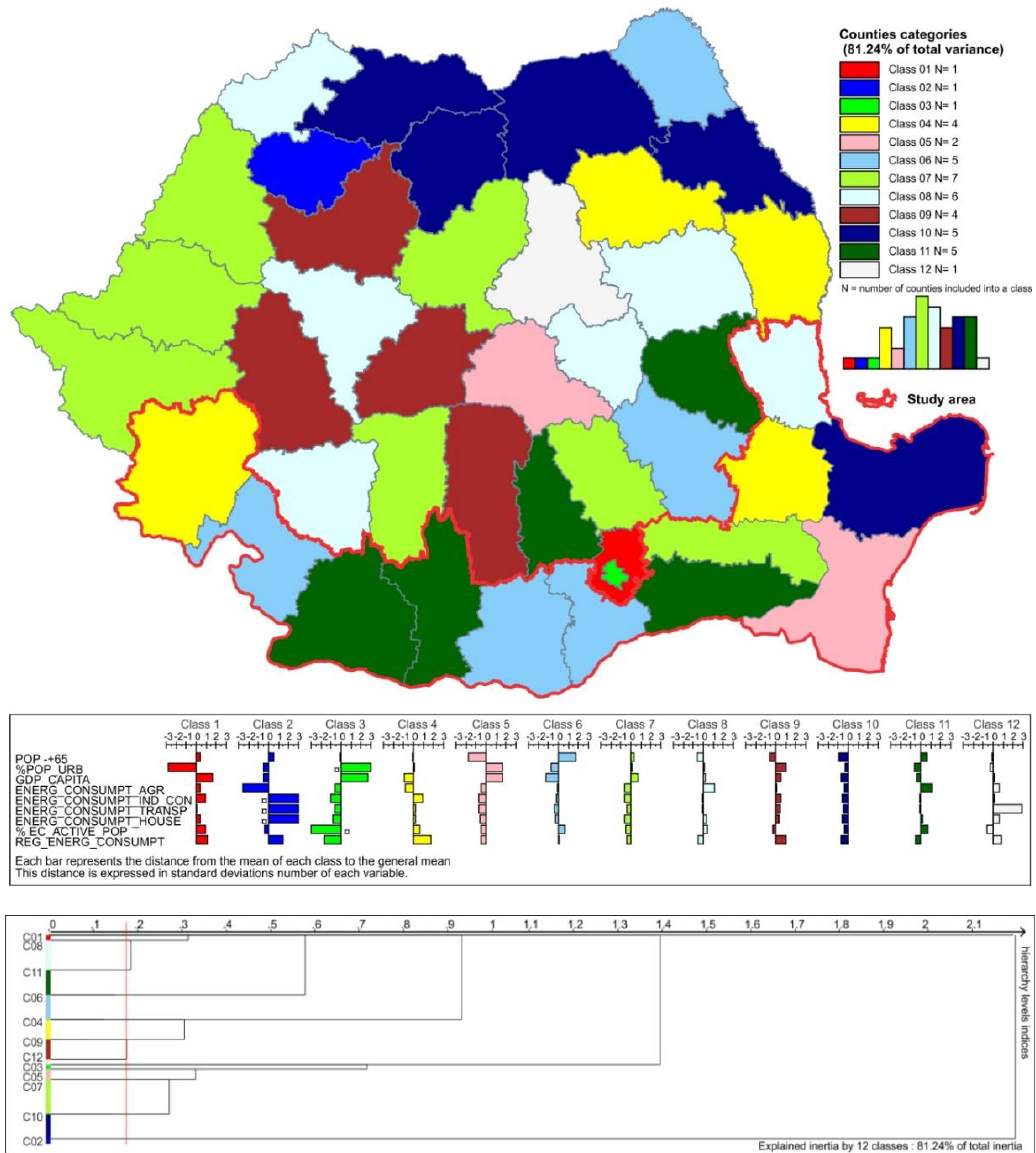
Figure 2. Spatial distribution of the demographic and economic indicators in 1995 (Source: TEMPO Online, National Institute of Statistics), (made with Philcarto, http://philcarto.free.fr).